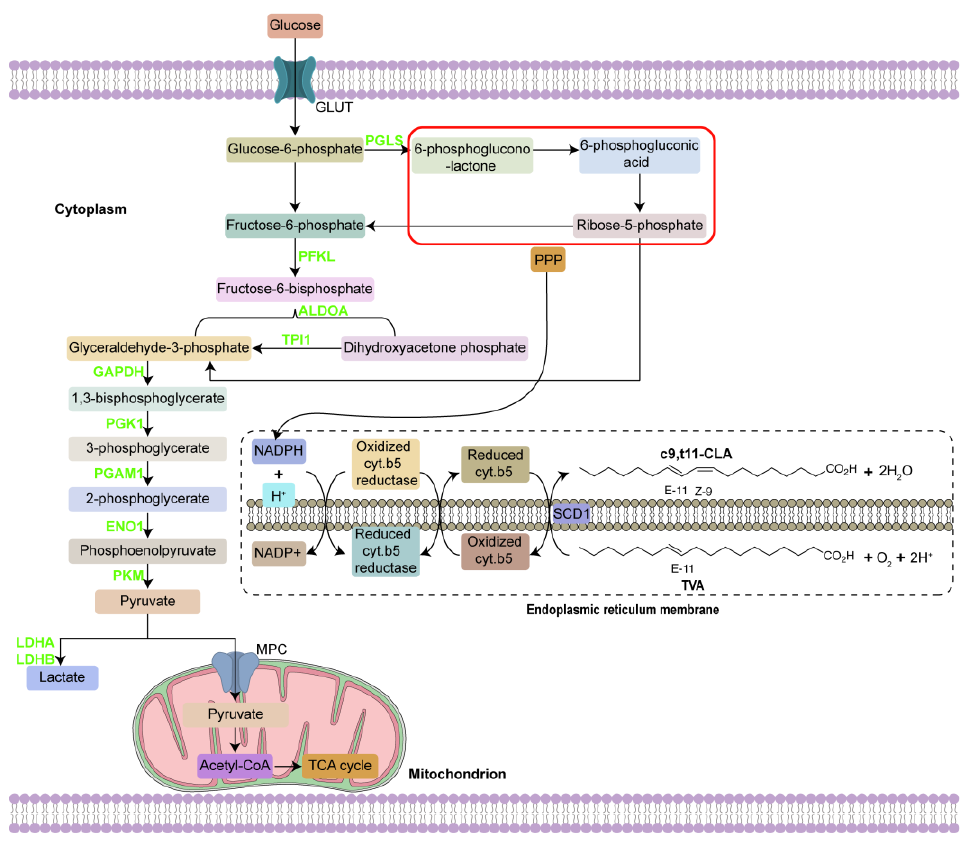
Figure 10. The SCD1-dependent gene network of c9, t11-CLA biosynthesis from the perspective of energy metabolism. The green color protein indicates that they were verified to have negative relationships with SCD1.